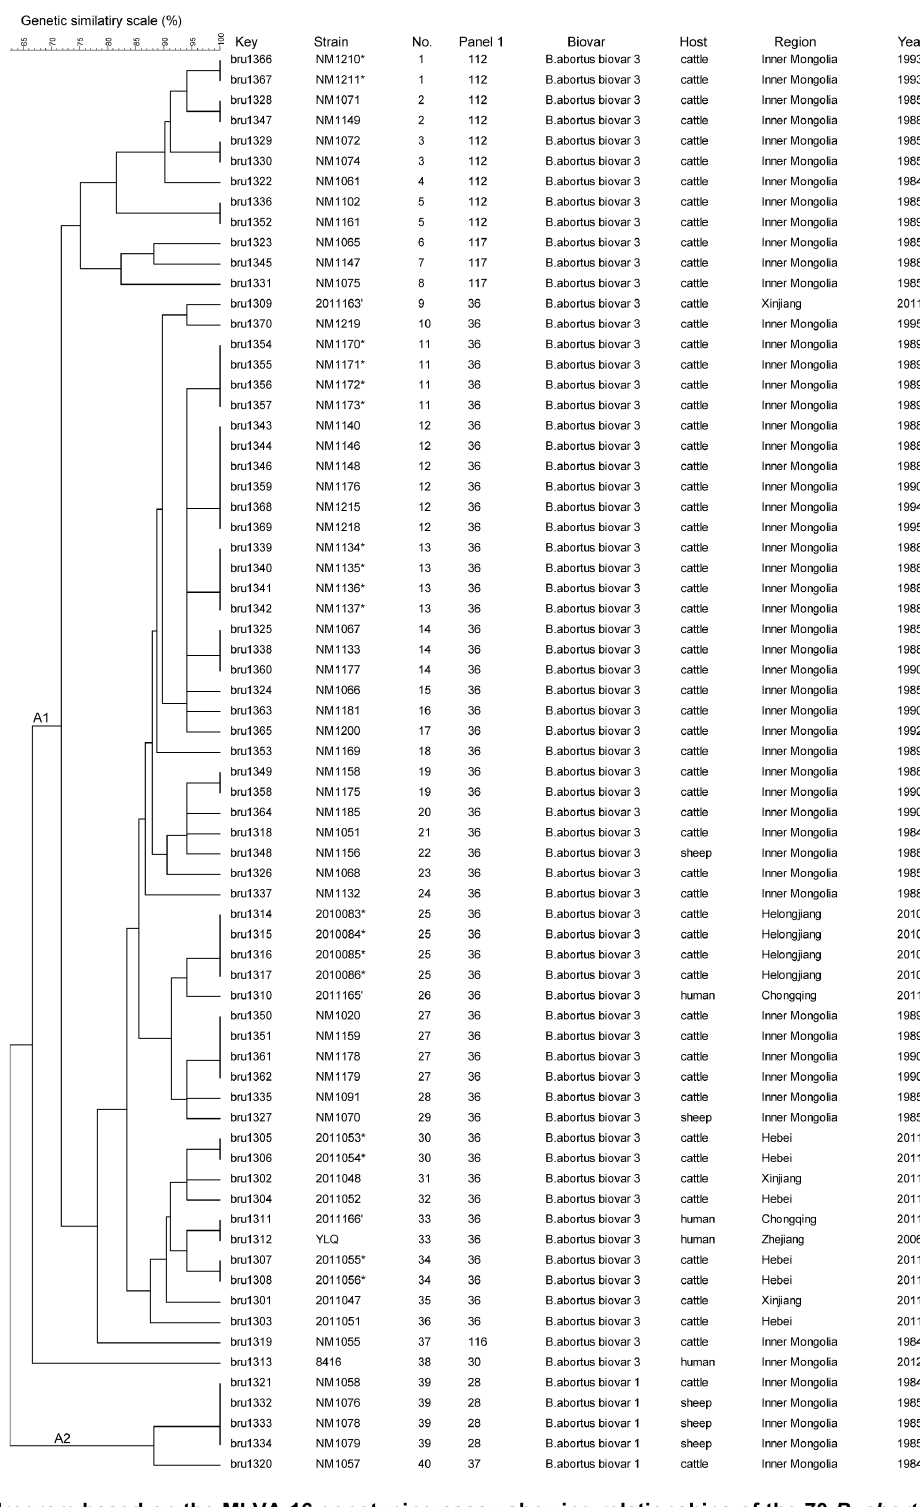
Figure 2. Dendrogram based on the MLVA-16 genotyping assay showing relationships of the 70 B. abortus strains in this study. In the columns, the following data for isolates are indicated: Key: serial number for the isolate in the Brucella2012MLVA database (Key), strain name in the laboratory (strain), genotype numbering (No.), Panel1 genotypes corresponding to each isolate in the Brucella2012, geographic region (Region), year of isolation (Year). Clusters of outbreak isolates are marked with an asterisk. doi: 10.1371/journal.pone.0076332.g002 PLOS ONE | www.plosone.org